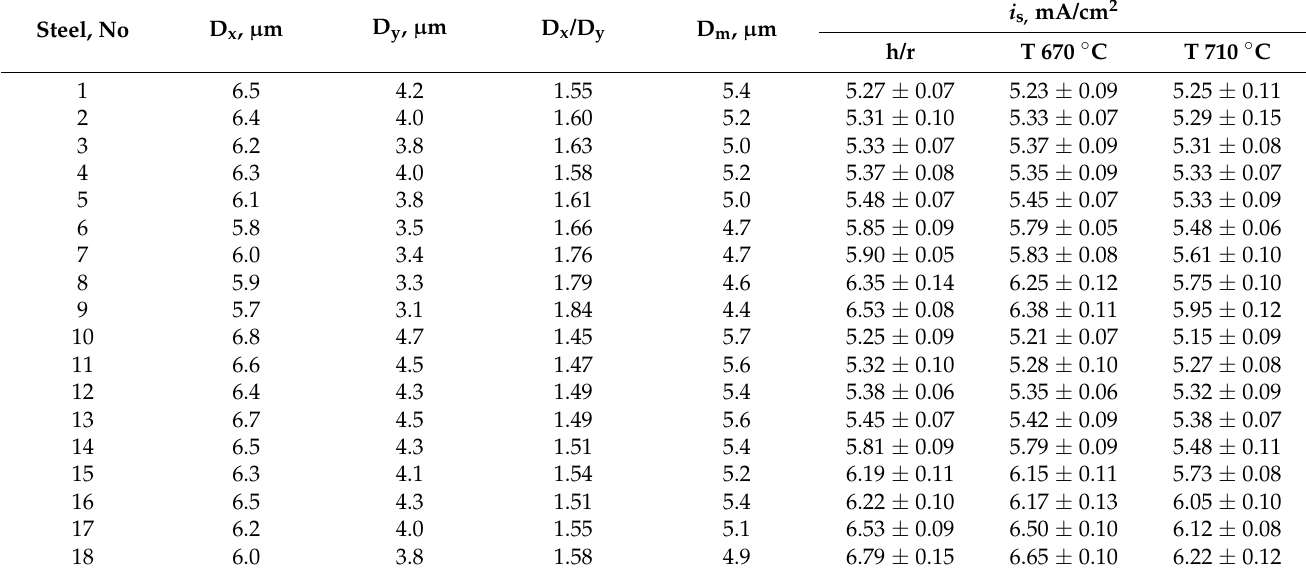
Table 2. Grain structure characteristics and indicators of corrosion resistance of the investigated